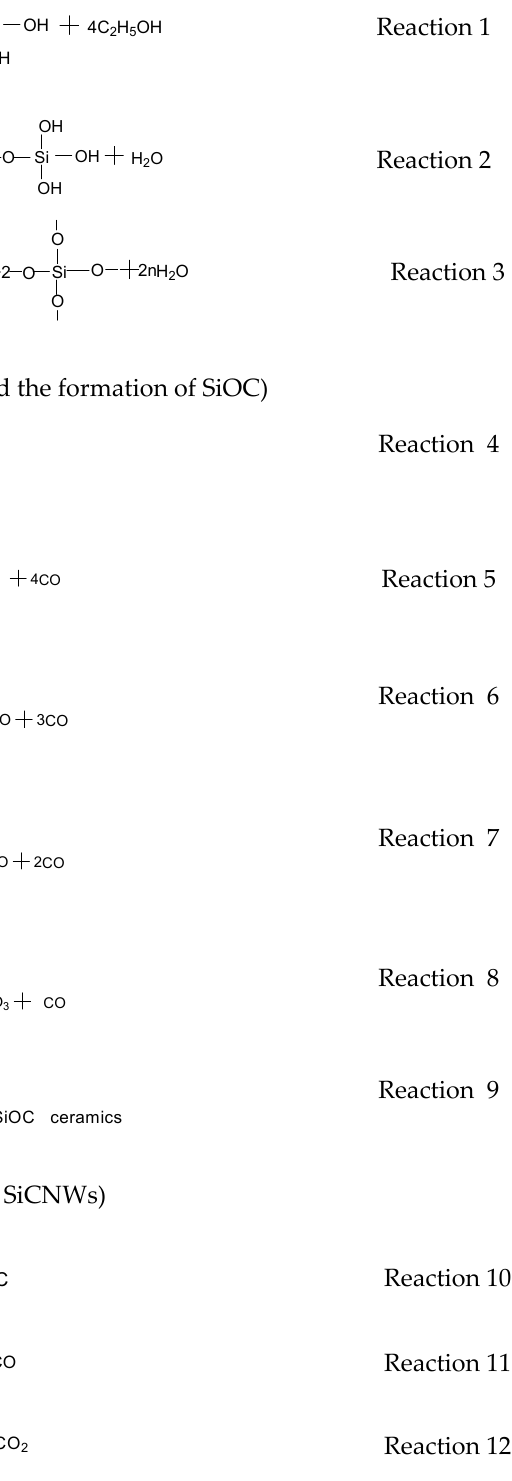
Scheme 1. The possible reaction mechanism.